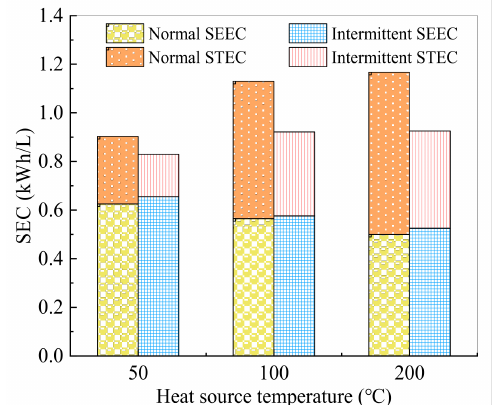
Figure 7. Comparison of SEC with and without intermittent heating at different heat source